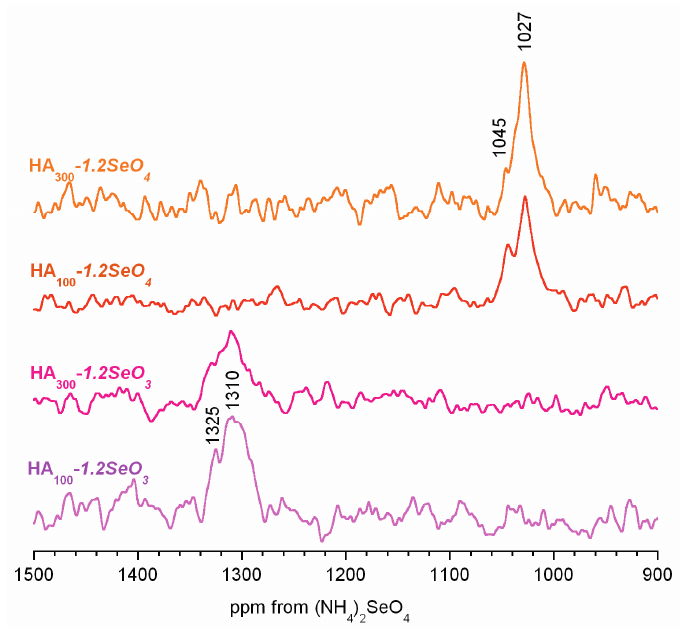
Figure 6. The 1 H → 77 Se CP NMR spectra for the selenium containing samples. Samples of HA 100 -1.2SeO 3 and HA 100 -1.2SeO 4 were dried at 100